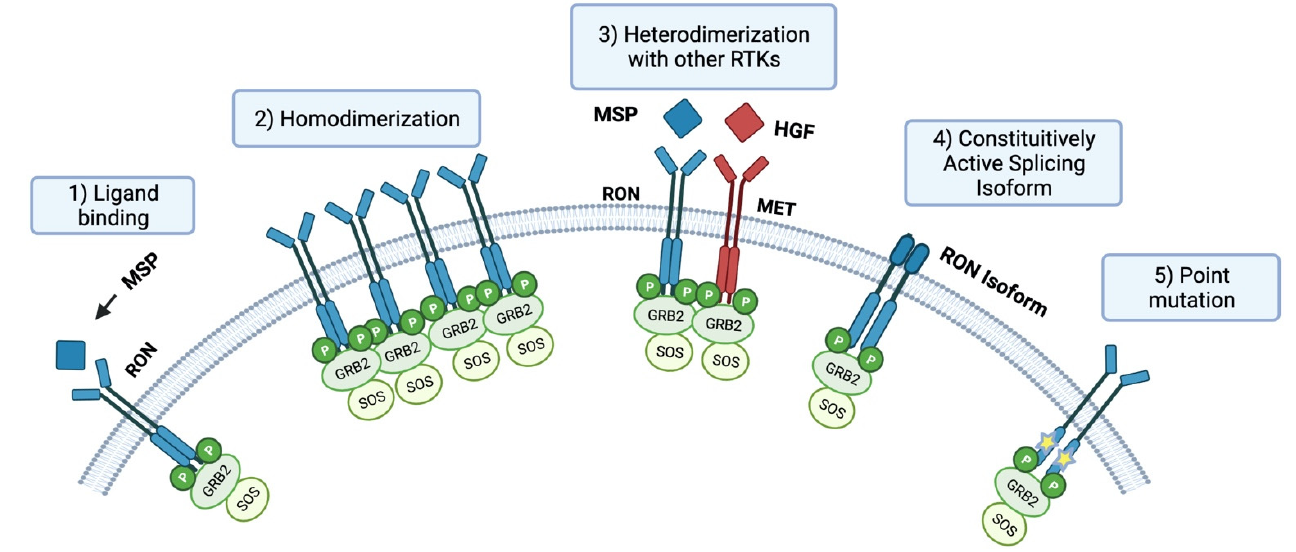
Figure 1. Ron Activation: ( 1 ) Classical activation via MSP ligand binding induces dimerization and activation. ( 2 ) Ron overexpression facilitates ligand independent activation via homodimerization.